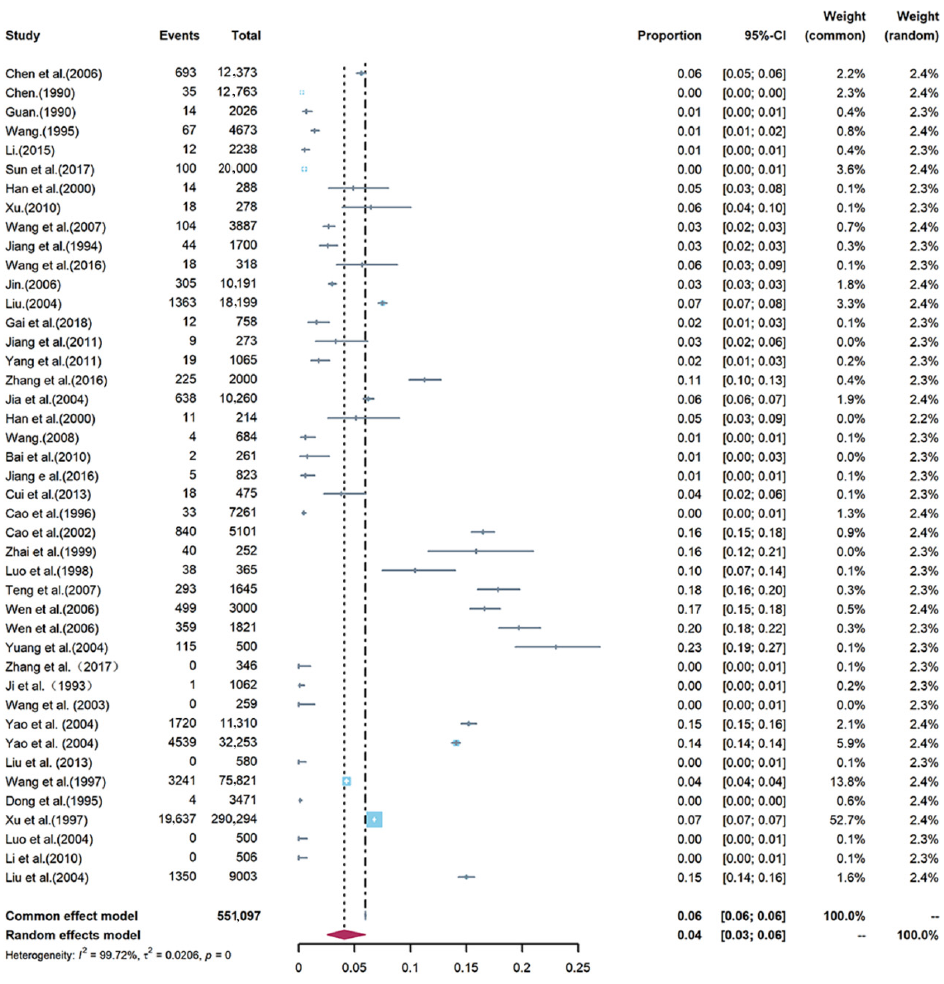
Figure 2. Forest plot showing the pooled prevalence of Trichinella spiralis in domestic pigs in China. The length of the horizontal line represents the 95% confidence interval and the diamond represents the summarized effect